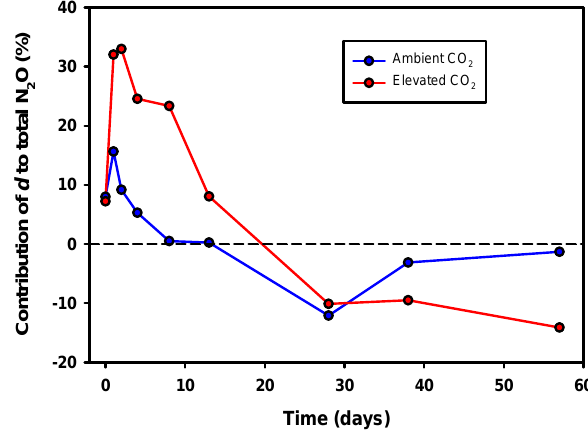
Fig 5. Contribution of d (NO 3— reduction) to total N 2 O production in grassland soil at ambient and elevated CO 2 . Fig. 5. Contribution of d (NO − reduction) to total N 2 O production 3 in grassland soil at ambient and elevated CO 2